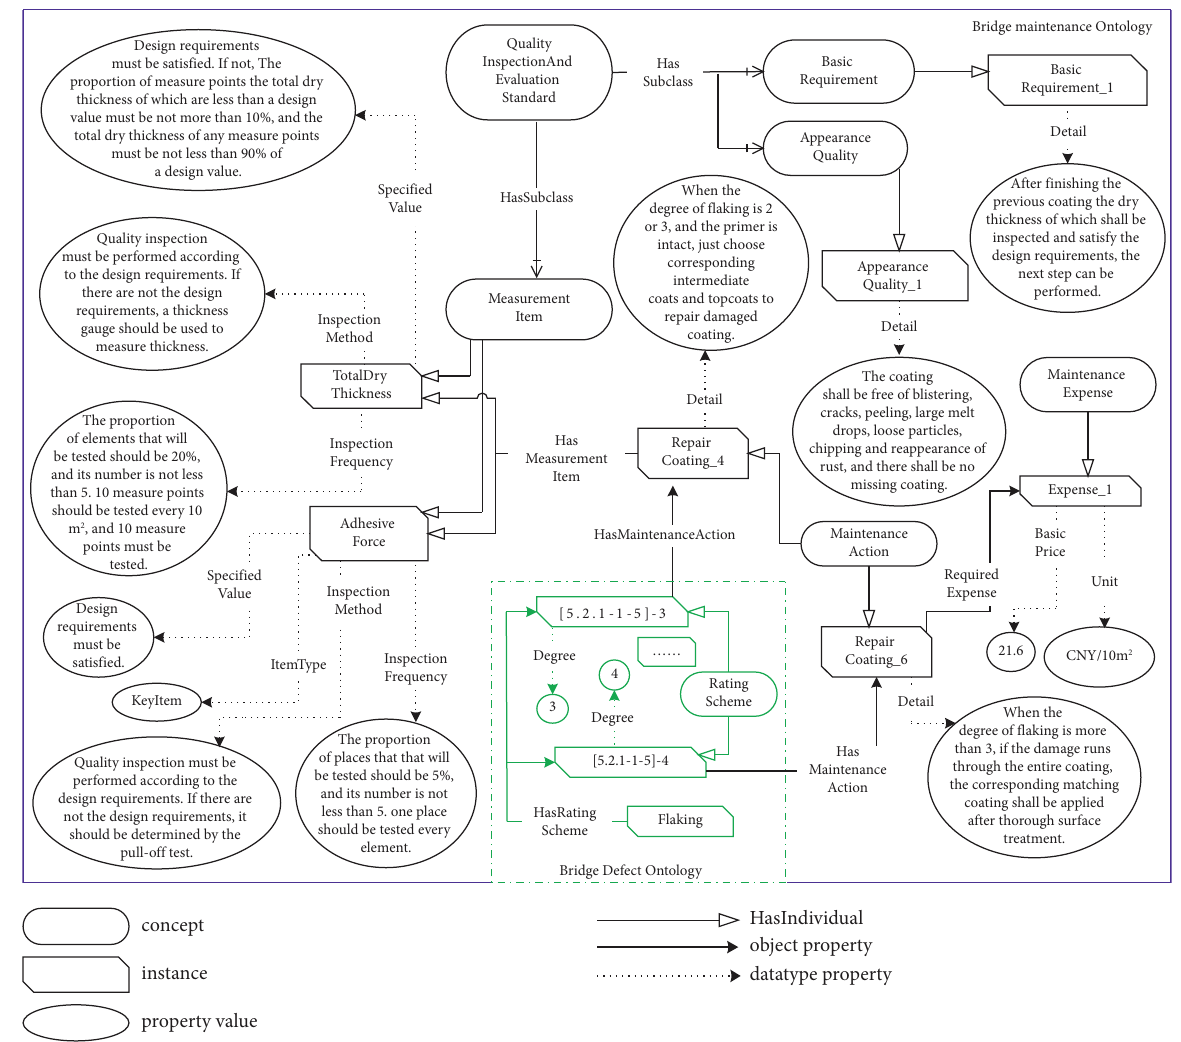
Figure 6: A schematic of the bridge maintenance ontology (partial